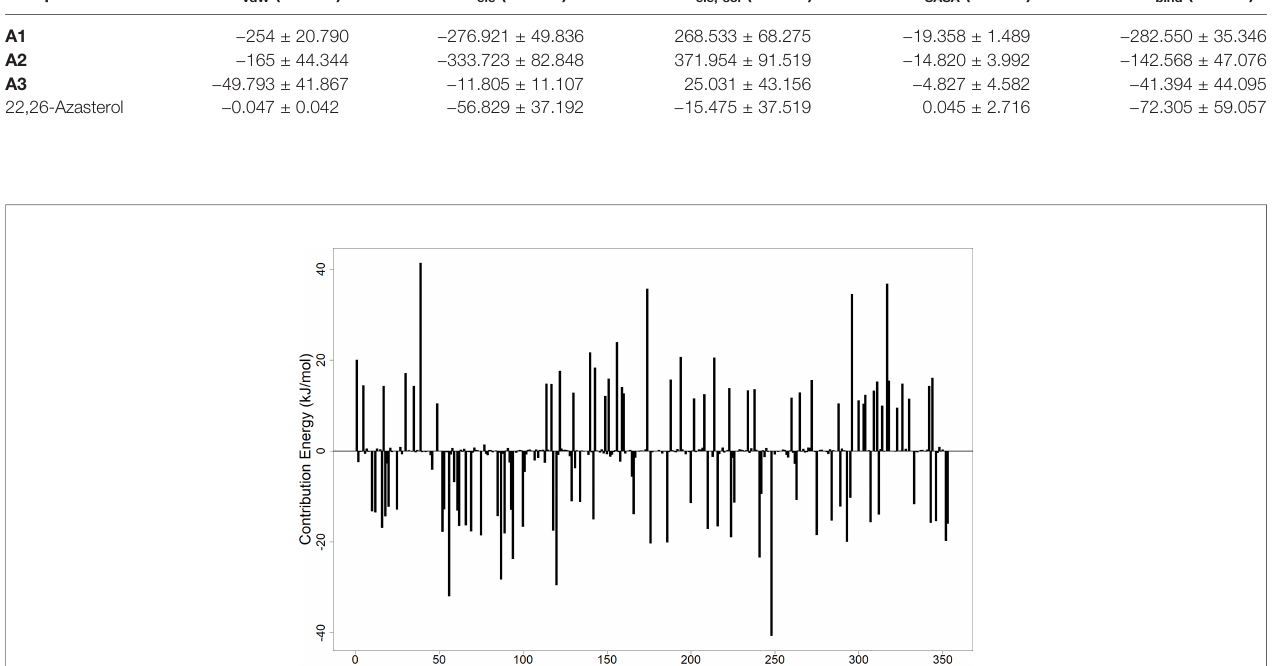
TABLE 3 | MM-PBSA energy assessment of the de-novo hits and 22,26-azasterol. Complex